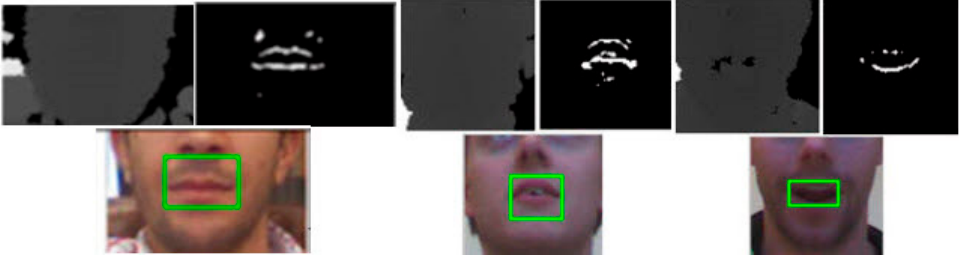
Figure 7. Results of detecting closed mouths (second row) by applying the adaptive mask on the depth image (first row) for 4 different